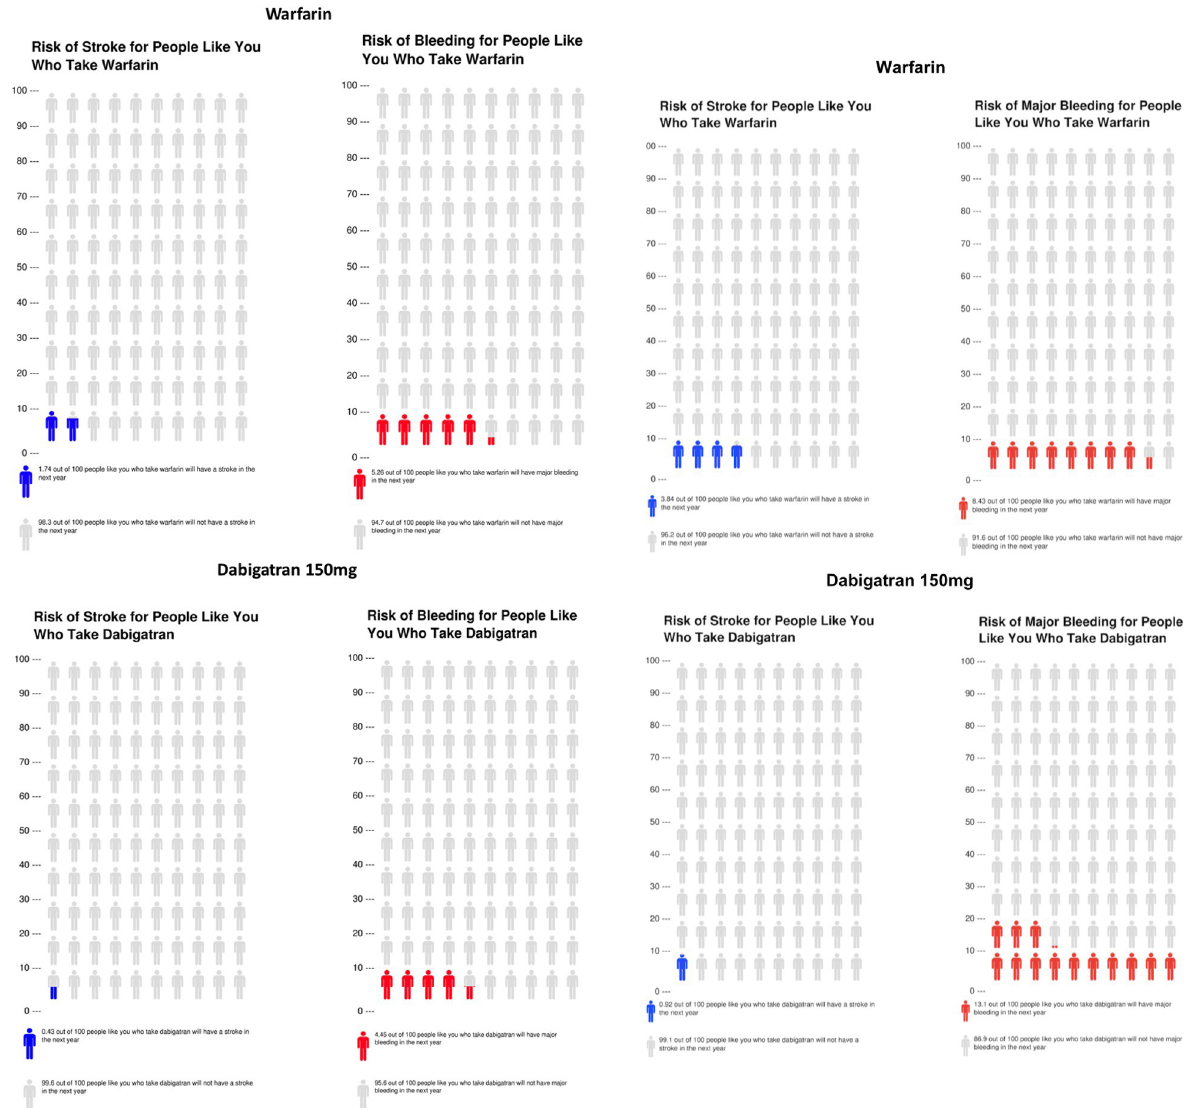
Fig 4. Icon Array decision-aids for two model patients showing the risks of stroke or systemic embolism and major bleeding with warfarin (top) and dabigatran 150mg (bottom). Panel A shows the risks for Patient A, a 68-year-old, 50-kg woman from the United States who has a history of heart failure, has a creatinine clearance of 49 ml/min, has paroxysmal AF, is not taking aspirin, and has no history of diabetes, stroke, systemic embolism, TIA. Panel B shows the risks for Patient B, a 62-year-old, 85-kg man, from the United States, with diabetes, a creatinine clearance of 85 ml/min, has a history of TIA, has permanent AF, is taking aspirin, and has no history of heart failure.